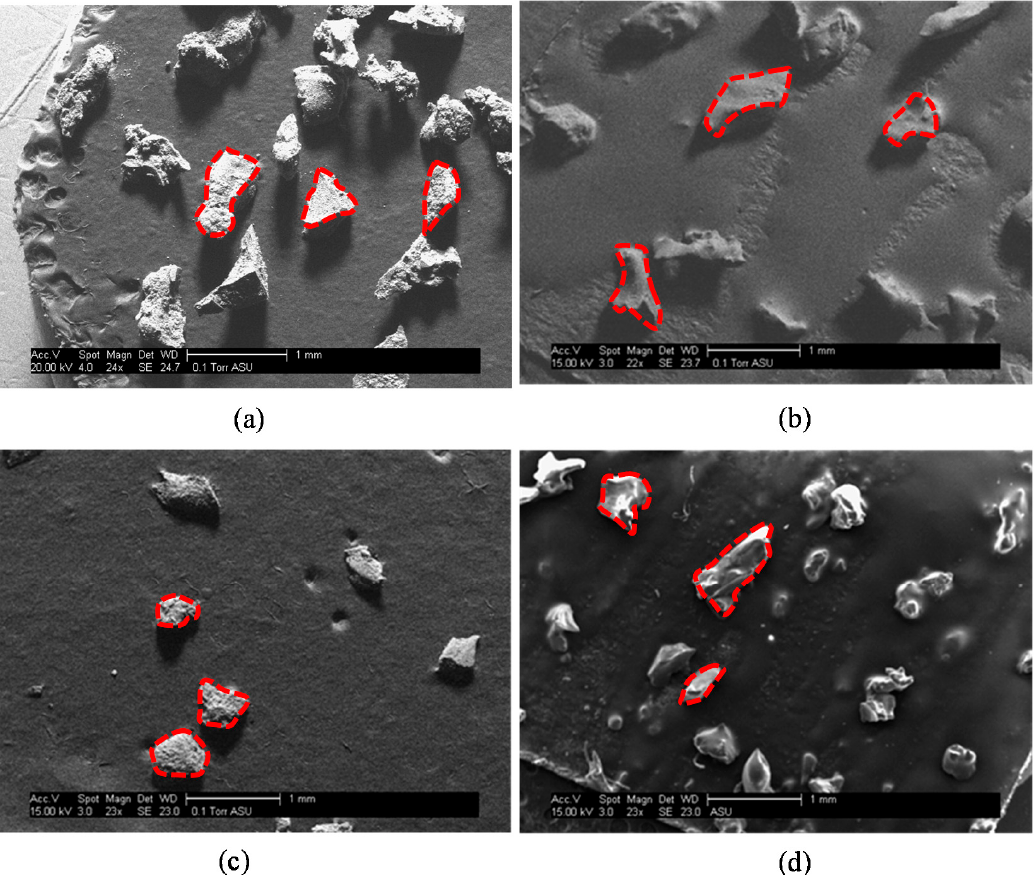
Figure 6. SEM images illustrating the ( a ) pre-blended and ( b ) post-blended 0.420 rubber particles, and the ( c ) pre-blended and ( d ) post-blended 0.297 mm rubber particles. (Adapted with permission from ref. [19], Copyright 2017 Elsevier).